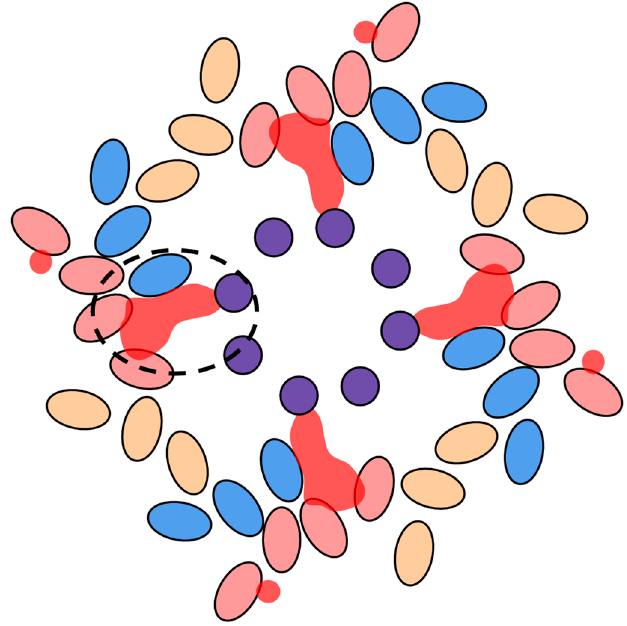
Figure 2. Graphical view down the filament axis (redrawn from a frame of Hu et al., movie S3 [2]). Ovals represent myosin dimers with the color (pink, yellow, blue) representing individual layers. The red density is shown in a translucent red and is circled at the multiface (dashed oval). Here, the red density contacts three LMM interfaces simultaneously with two dimers belonging to the ‘pink’ layer and one dimer belonging to the ‘blue’ layer. Contact with paramyosin (purple circles) is made at the center of the thick filament.